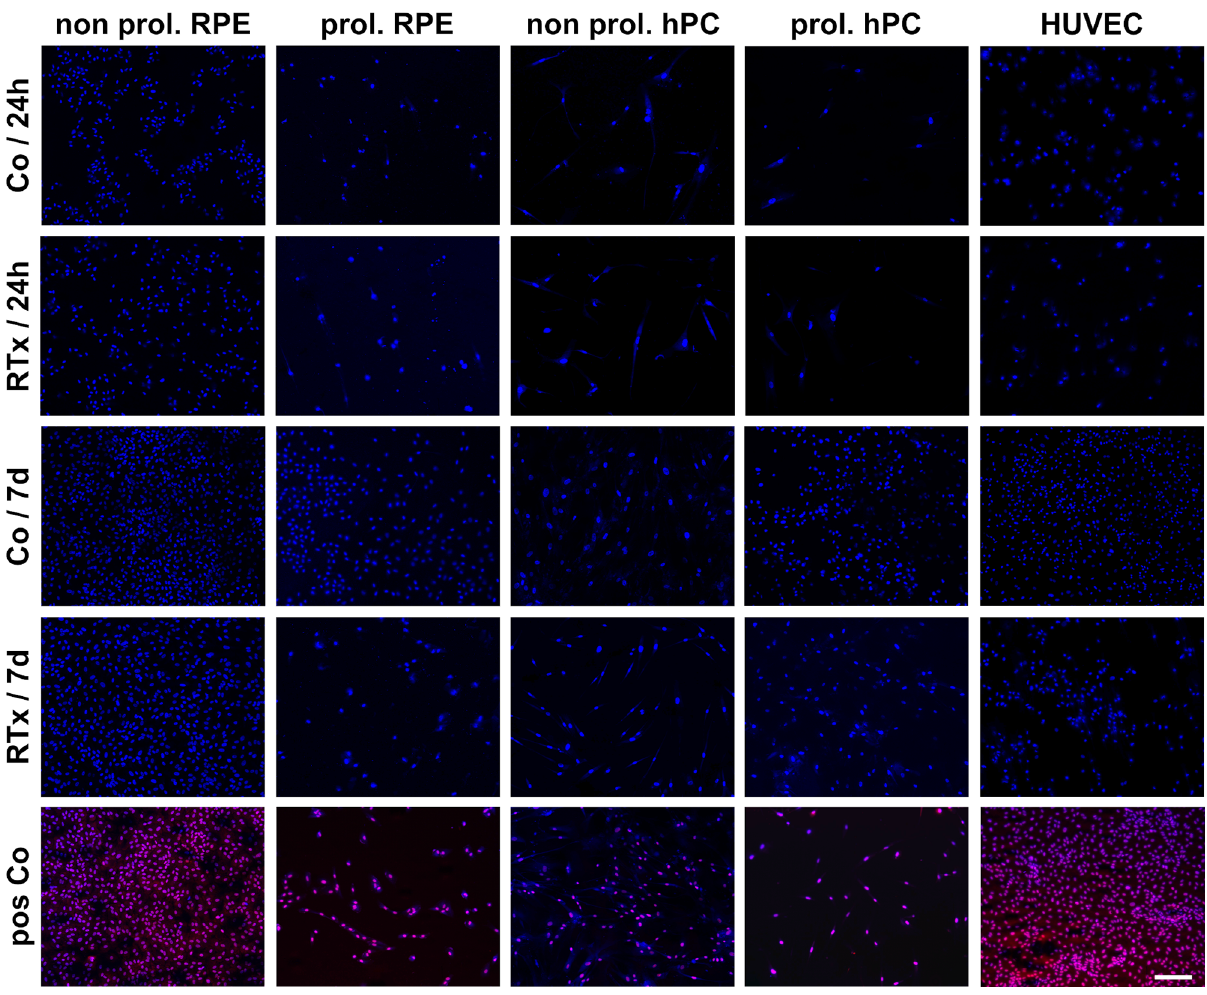
Figure 1. Irradiation does not induce apoptotic cell death of RPE, hPC and HUVEC. Life / Dead staining with Hoechst 33,342 (blue) and propidium iodide (red) was performed 24 h (24 h) and 7 days (7d) after irradiation treatment with 16 Gy (RTx). Magnification bar: 200 µm. Co: untreated control cells; RTx: irradiated cells. Figure was created using Graph Pad Prism 8 (Version 8.4.3.; www. graph pad.